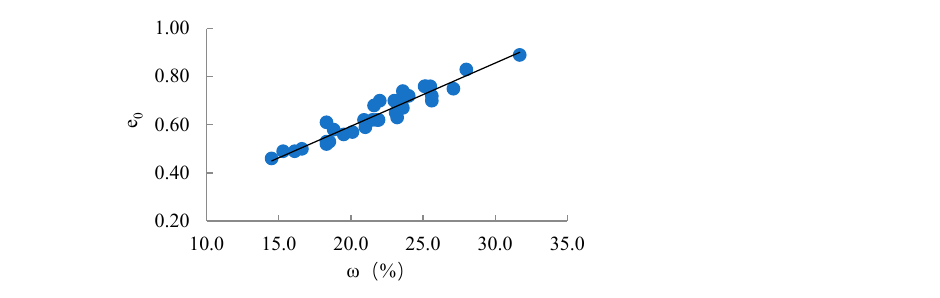
Figure 5. Correlation diagram of initial void ratio e 0 and natural moisture content ω in soil.